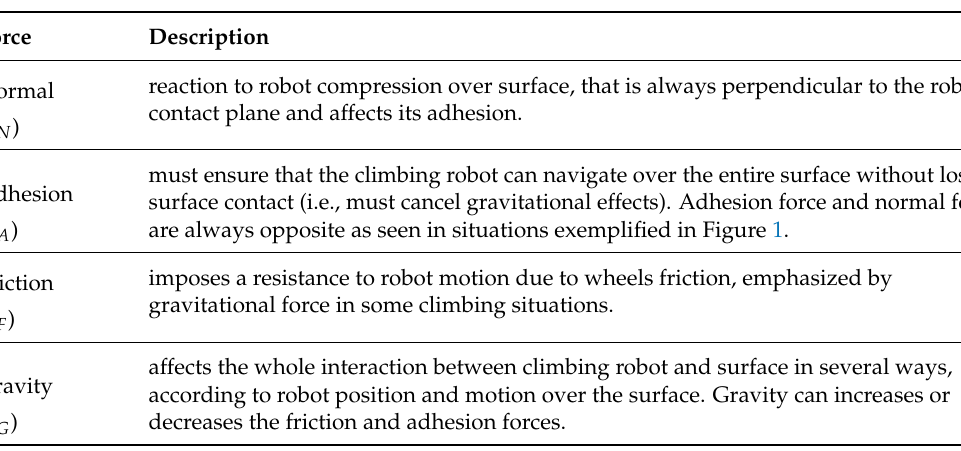
Table 1. Forces in climb interaction.